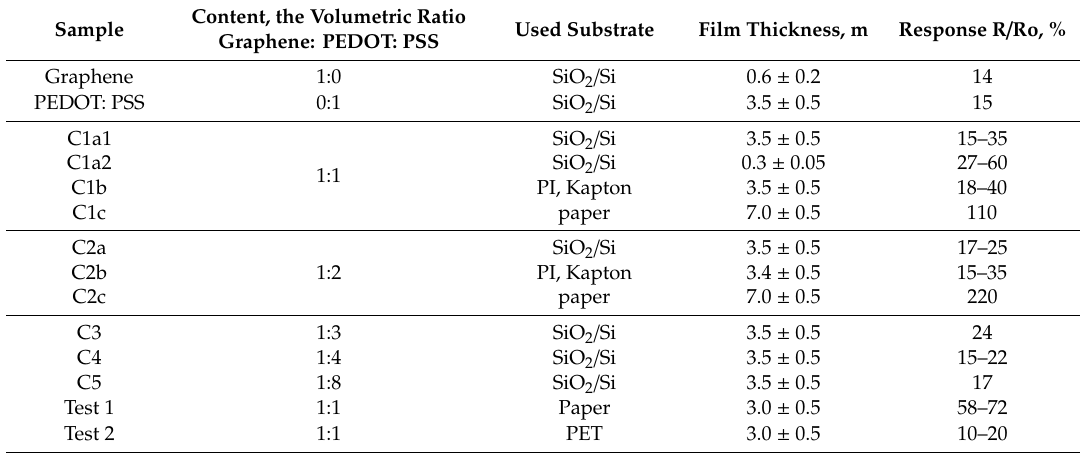
Table 1. Nomenclature and characteristics of the structures prepared from the graphene: PEDOT: PSS composite material. R/R o is the response of humidity sensor, R/R o = (R(high humidity) − R o (low humidity))/R o [%]. High humidity was equal to 80%–90%, low humidity was equal to 20%–30%.